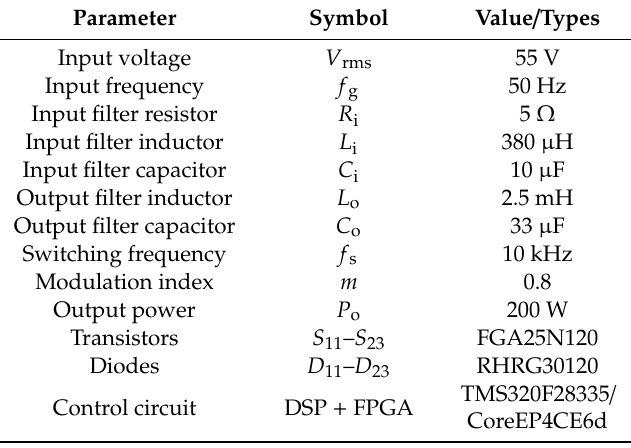
Figure 11. Experimental prototype of the proposed CSR. Table 5. Parameters of the experimental prototype.